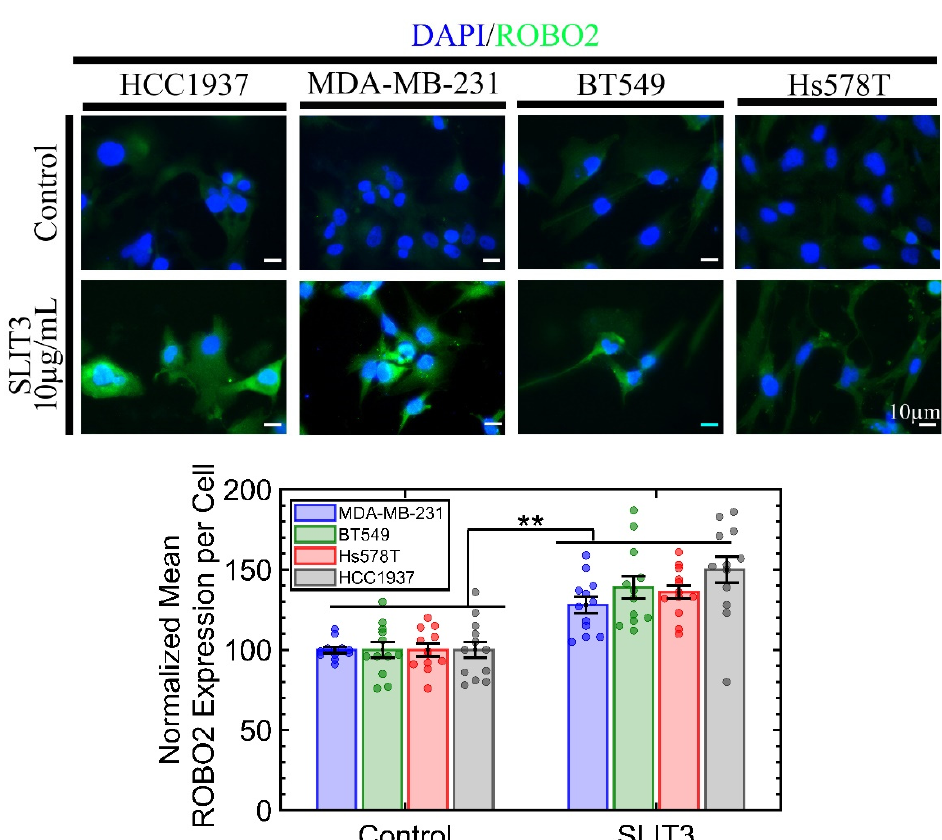
Figure 2. ROBO2 is overexpressed in all four TNBC cell lines when these cells are incubated with SLIT3. Hence, the ectopic SLIT3 reprograms cancer cells. Each condition had six replicates with at least two fields of view per well imaged. ** p -value < 0.001.